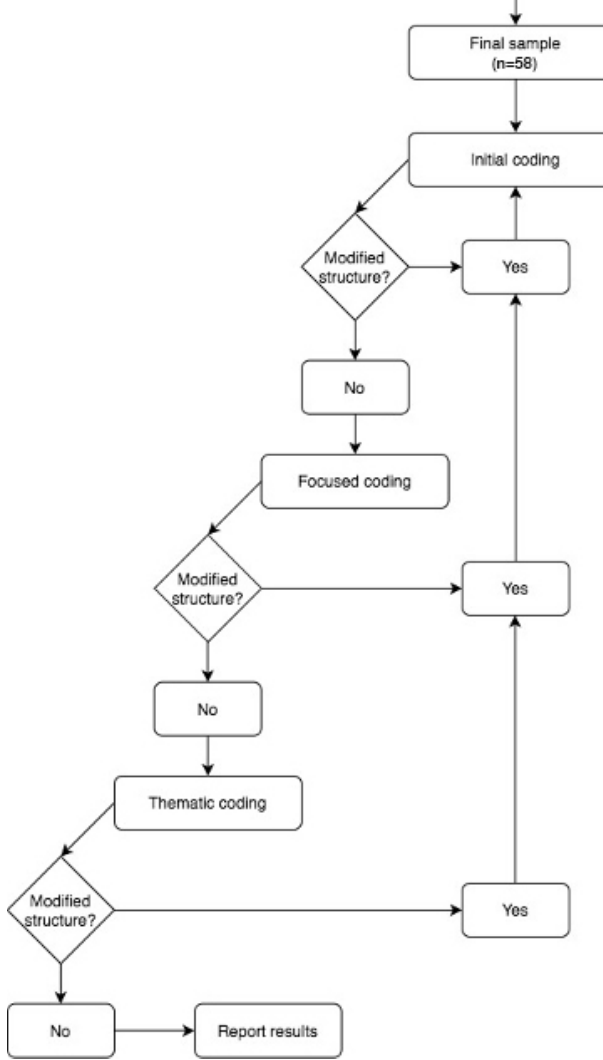
Figure 1. Overview of sampling procedure and analytic protocol.